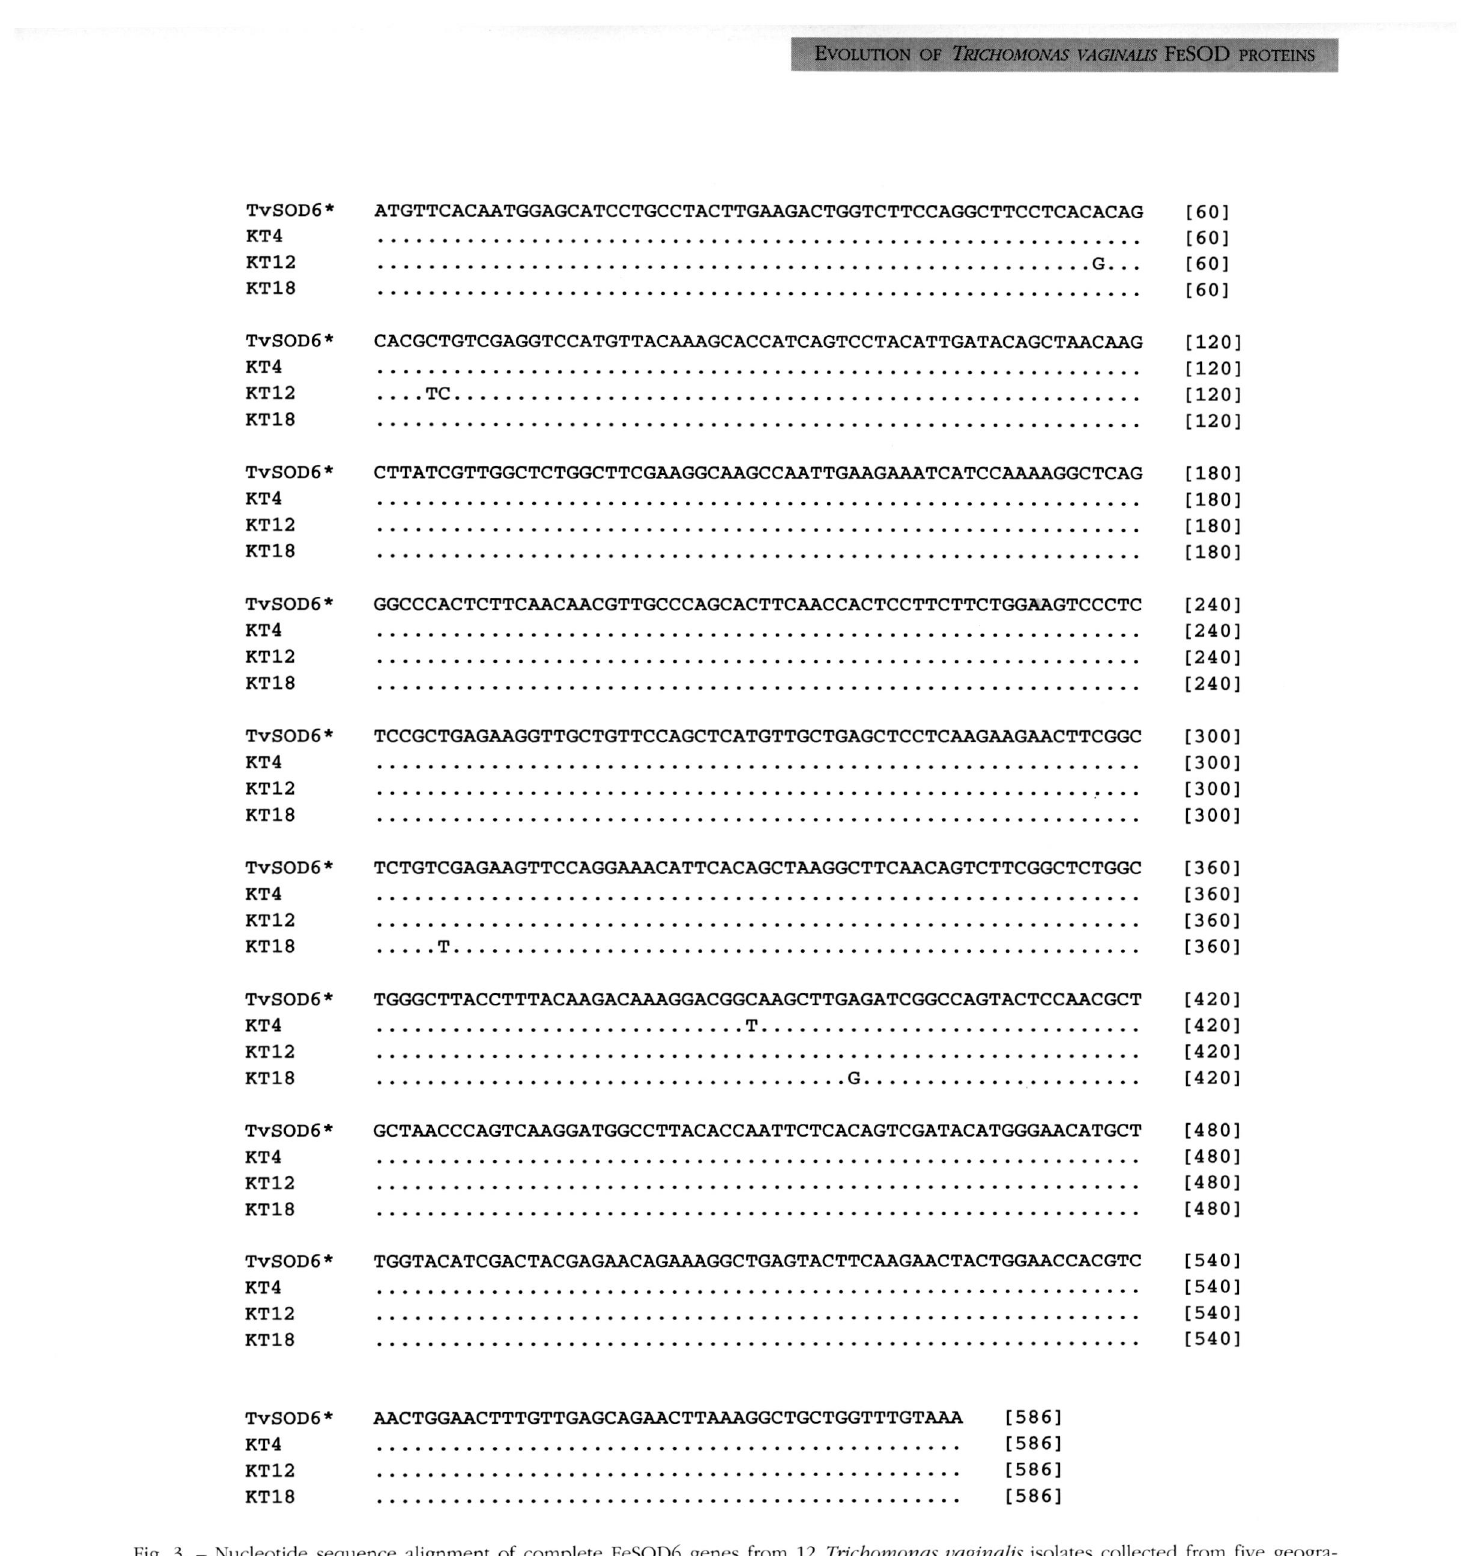
Fig. 3- - Nucleotide sequence alignment of complete FeSOD6 genes from 12 Trichomonas vaginalis isolates collected from five geogra­ phically distinct regions (six Korean, one Japanese, one Chinese, one Australian, and three American isolates) with previously reported one (TvSOD6). ' indicates that FeSOD6 gene sequences of the nine isolates (NYH286, CDC85, RU393, IR78, YA1, KT19, KT11, KT38, and KT40) are identical with that of the previously reported TvSOD6 gene (AF022423). Dots indicate nucleotide identical with those of the first line (TvSOD6). Refer to Table I for additional information of